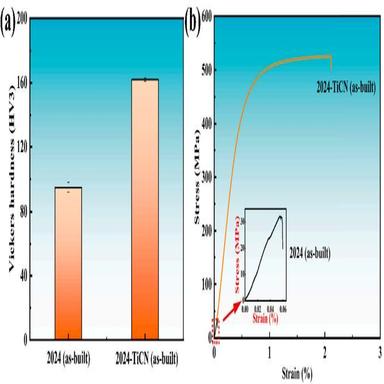
Mechanical properties for the LPBFed pure 2024 Al alloy and 2024-5 vol% TiCN composite, (a) Vickers hardness, and (b) tensile stress-strain curves.